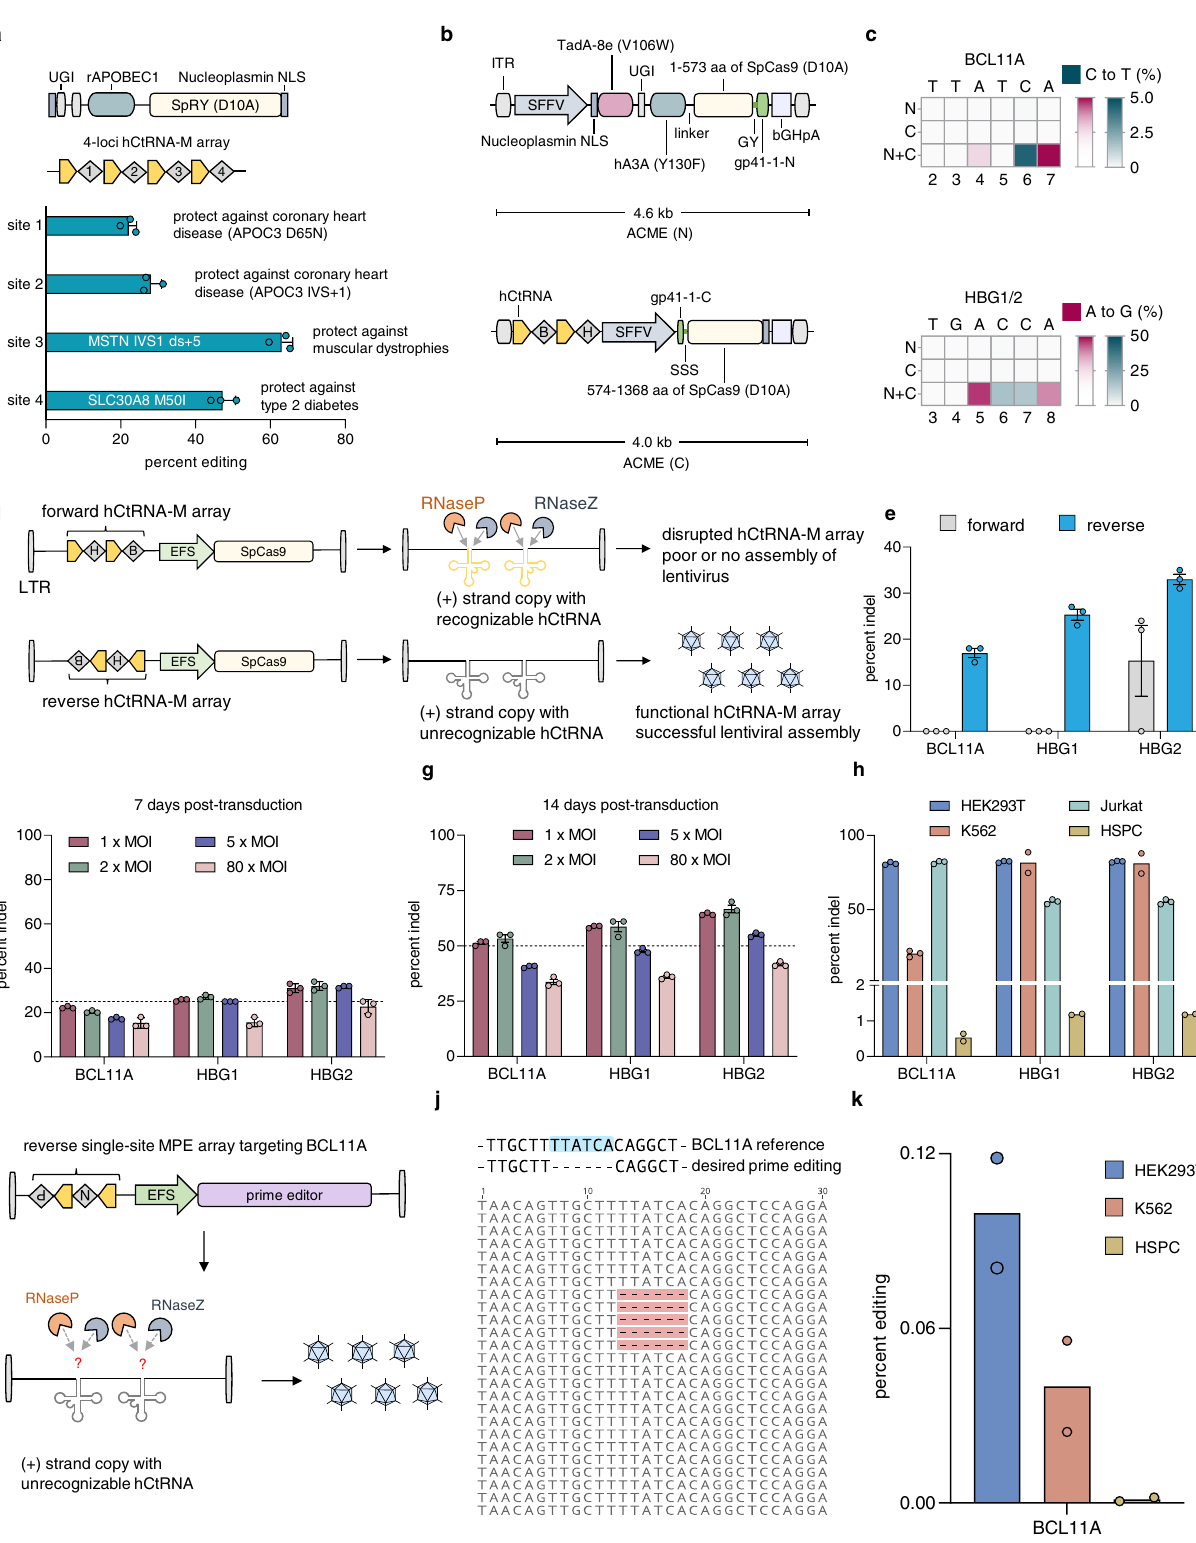
61.3 ± 2.1% (HBG1/2) (Supplementary Fig. 23a, Supplementary Fig.